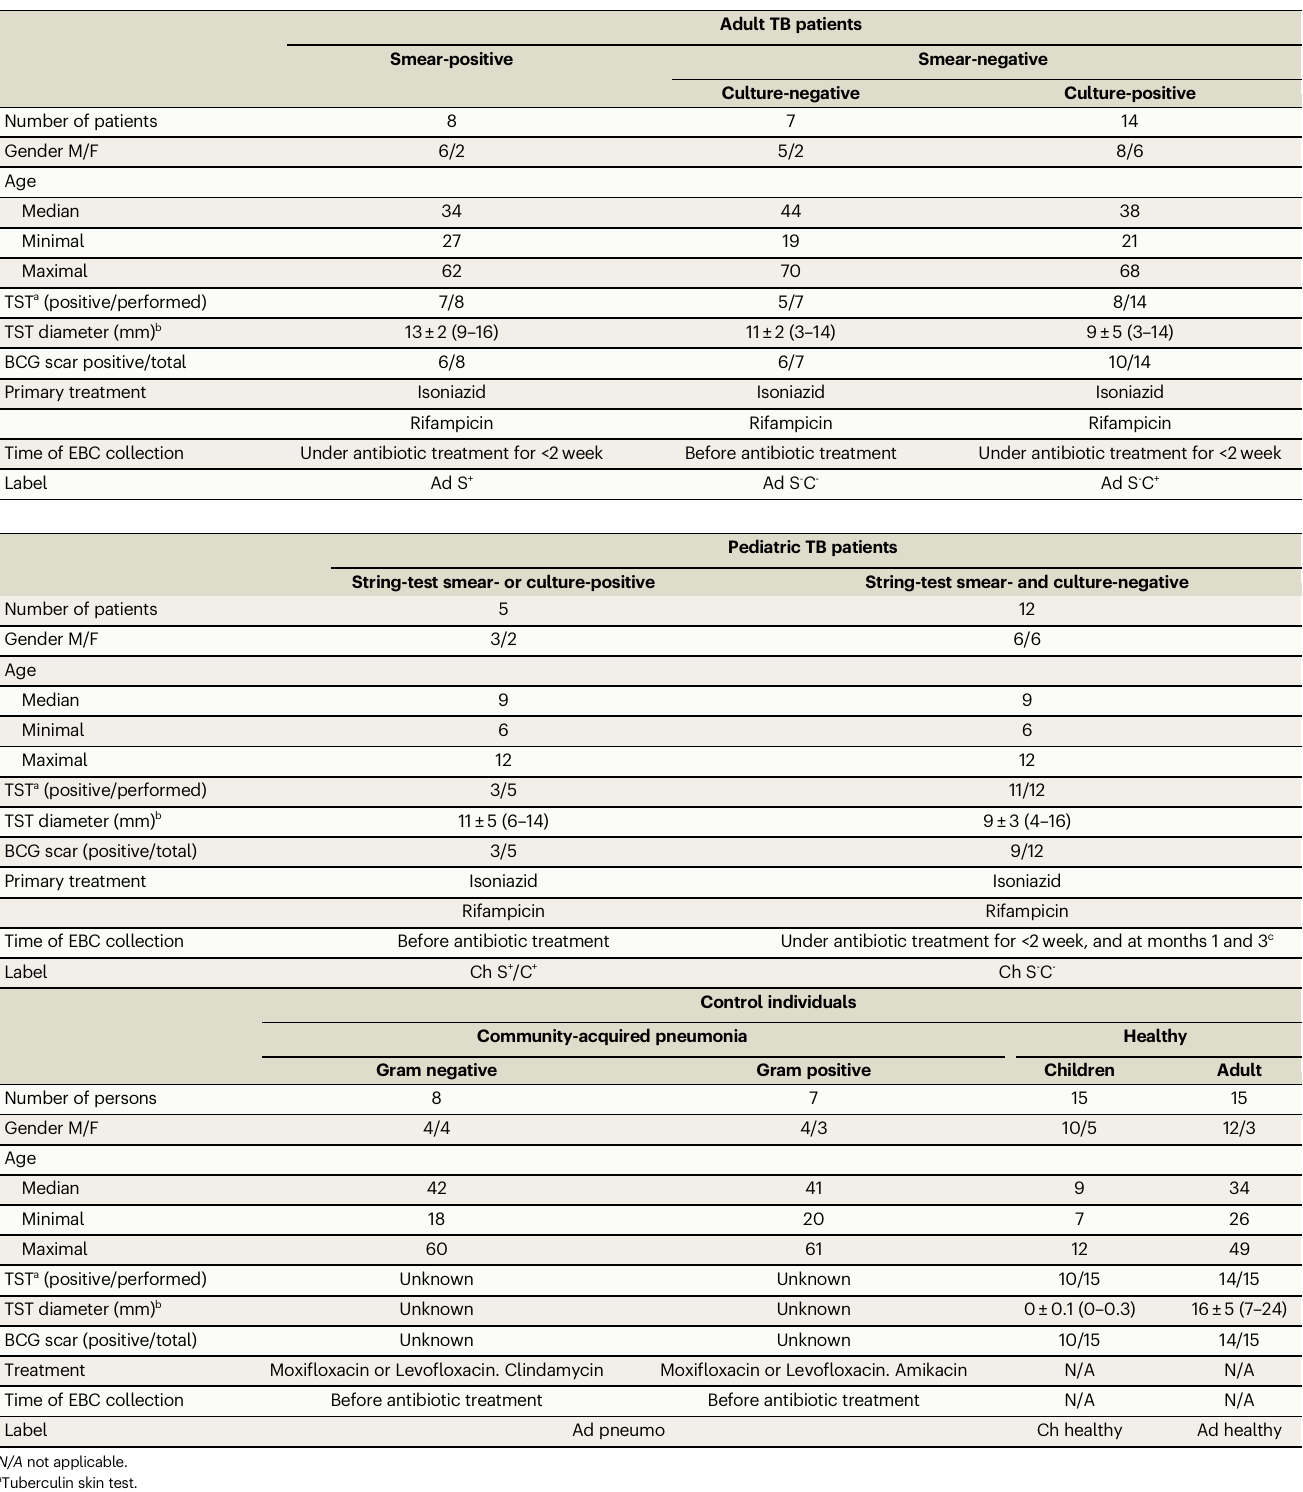
Table 1 | Clinical and demographic characteristics of the adult and pediatric TB patients, and control individuals, either healthy or with bacterial